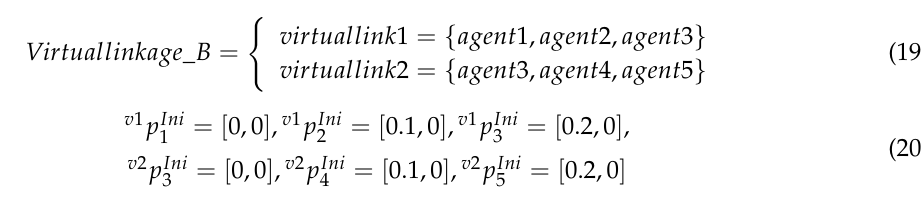
Figure 12. Detailed architecture of the hierarchical virtual linkage approach for simulation.